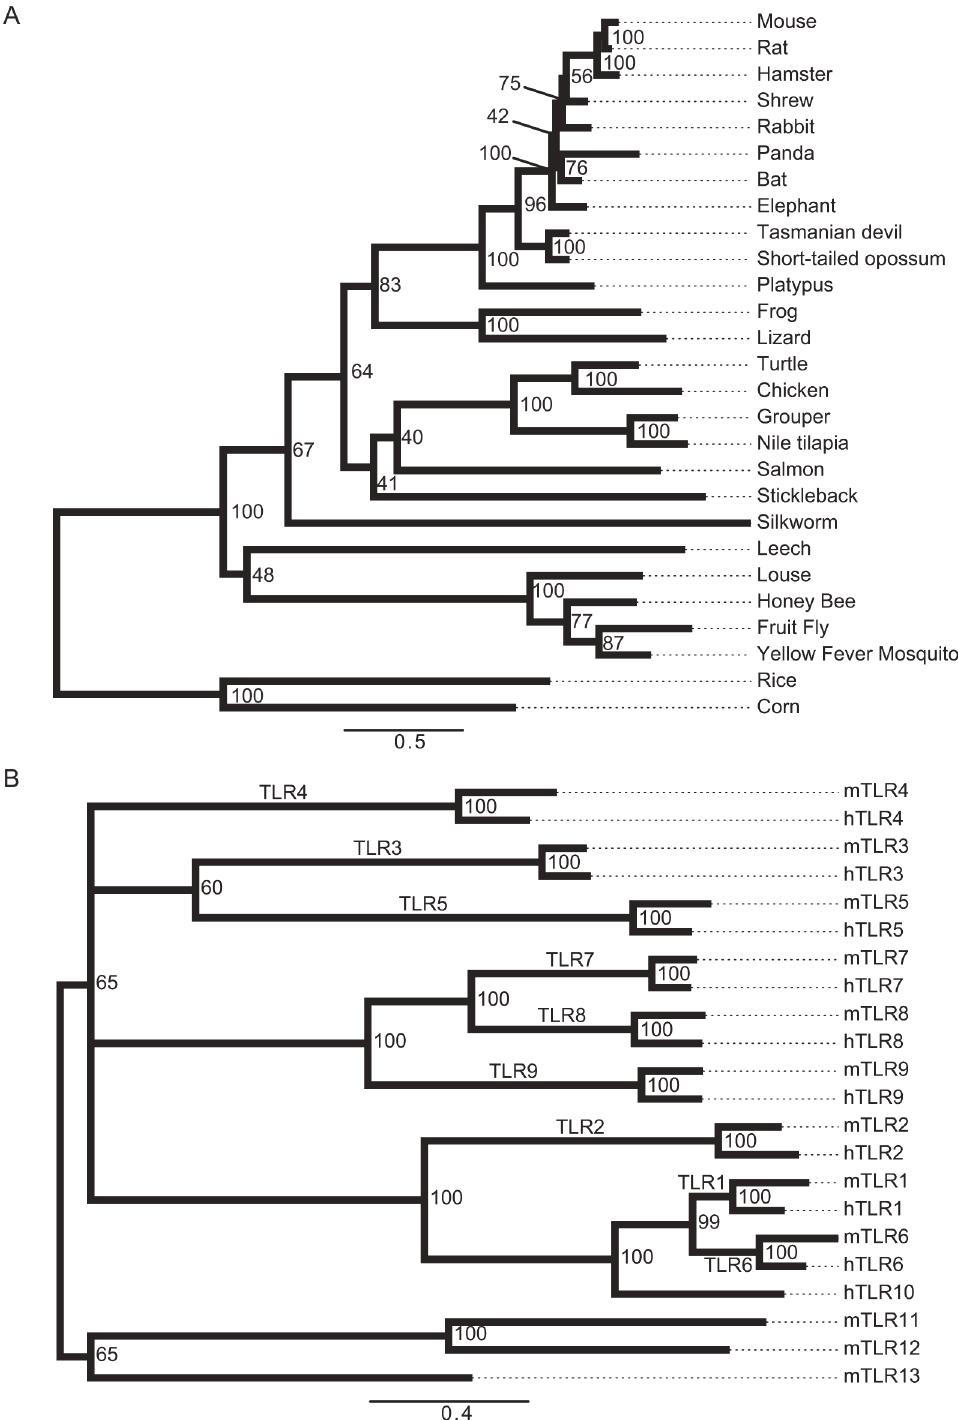
Fig 7. Phylogenetic analysis of TLR13 in species and of the TLR repertoires in humans and mice. (A) The phylogenetic tree displays a choice of species where we identified an ortholog to TLR13 using the OMA browser and NCBI Blast search. The hits were confirmed with FACT to test whether the predicted orthologs have similar feature architecture as the query protein. Thus, the orthologs are firstly similar in sequence and secondly similar in their feature architecture. Numbers at the branch points indicate bootstrap values. (B) The phylogenetic tree displays evolutionary relationship of human and mouse TLR proteins. The tree was constructed as described in (A). Note that if a particular TLR is found in both species then both orthologs exhibit very close evolutionary relationship (bootstrap value 100). The nucleic acid-sensing TLRs do not cluster in one branch: TLR7, TLR8 and TLR9 are found in a